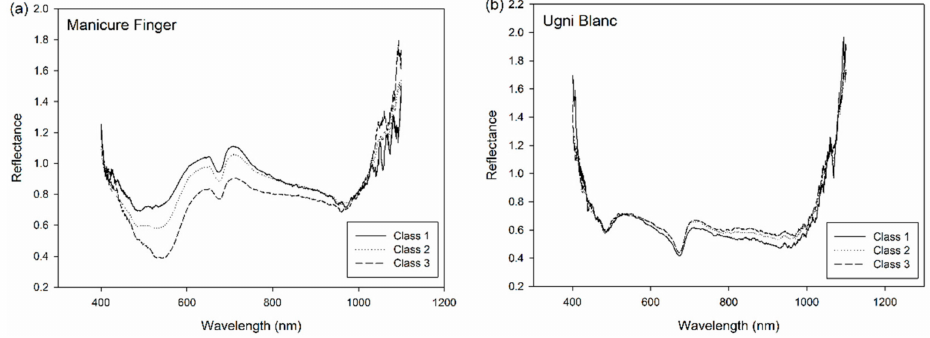
Figure 3. Mean reflectance spectra of ’Manicure Finger’ ( a ) and ’Ugni Blanc’ ( b ) in di ff erent